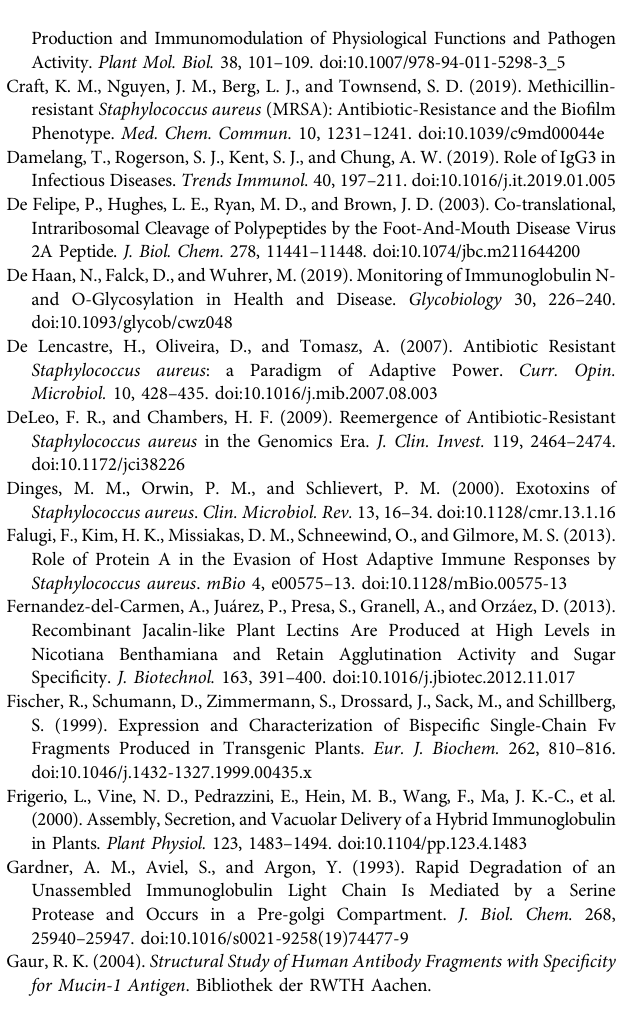
LPH – N-terminal leader peptide of the antibody mAb24 heavy chain, PCP – plant cell pack, Vac – vacuolar targeting. Supplementary Figure S5 | Comparison of model predictions (95% con fi dence interval, CI, orange lines) and veri fi cation runs (green diamonds at 25 mS cm − 1 ; blue diamondsat50 mS cm − 1 )forIgG3purityandrecoveryafterpuri fi cationbyproteinG chromatography.ThewashstepwasperformedatpH8.0and5.0 mS cm − 1 usinga contact time of 2 min in all experiments. Elution buffer conductivities up to 25 mS cm − 1 (always pH 2.0) were used to establish the descriptive models, which cannot be used for predictions at higher conductivities, i.e. at 50 mS cm − 1 used to test extreme conditions (blue diamonds). Independent of conductivity, model predictions and veri fi cation run performance matched well for purity, the model under-predicted the recovery, most likely due to scale-effects. Supplementary Table S1 | Primers used to generate expression vectors for target proteinexpressionintheapoplast,vacuoleandplastids,aswellasIgG3domainexchange variants, starting from two IgG1/3 base constructs ( Supplementary Figure S1 ). Supplementary Table S2 | Expression vectors used to assess IgG3 production in Nicotiana spp. Supplementary Table S3 | Model factors with a signi fi cant in fl uence on IgG accumulation and integrity during transient expression in BY-2 PCPs as identi fi ed by restricted maximum likelihood analysis. Supplementary Table S4 | Model factors with a signi fi cant in fl uence on IgG purity and recovery after protein G chromatography as identi fi ed by analysis of variance